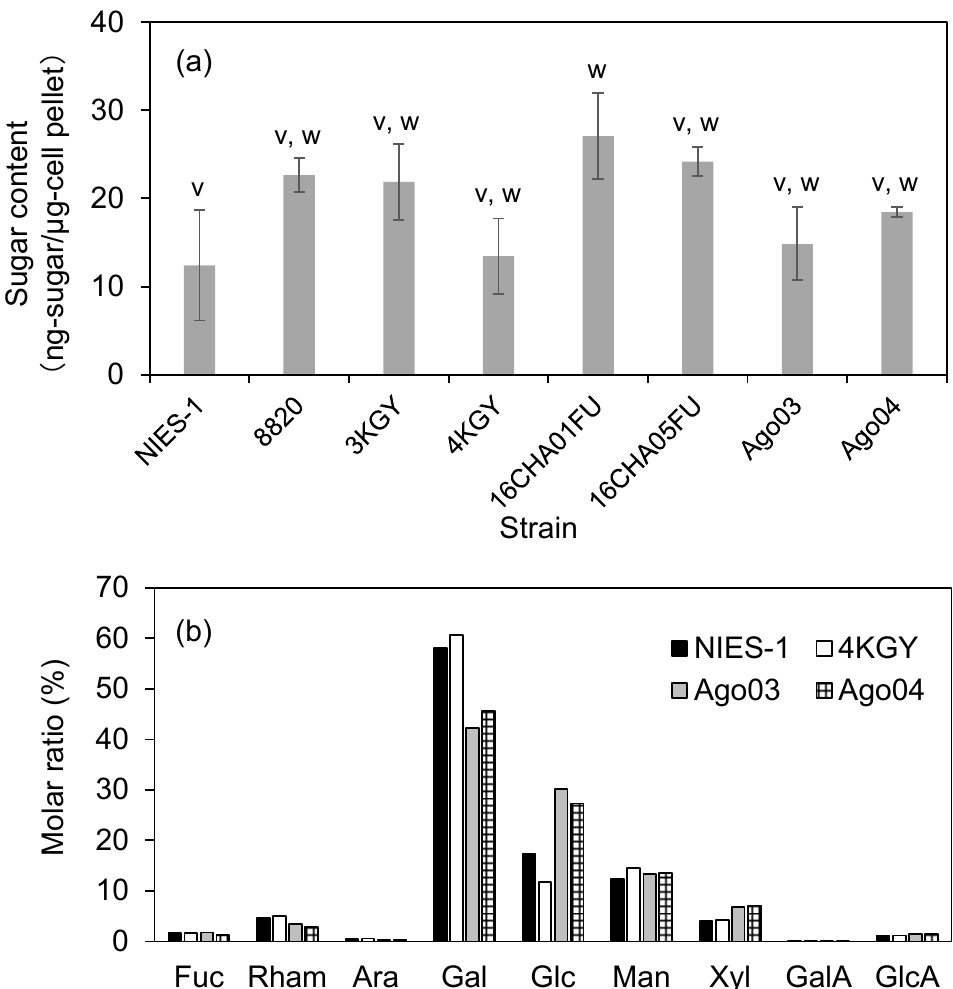
Figure 9. Sugar content ( a ) and composition of monosaccharides ( b ) of Chattonella strains. Each bar represents the mean ± SD of triplicate measurements. Means that are not significantly different are labeled with the same letter (v or w; p < 0.05). Abbreviations of sugars are as follows: Fuc, fucose; Rham, rhamnose; Ara, arabinose; Gal, galactose; Glc, glucose; Man, mannose; Xyl, xylose; GalA, galacturonic acid; GlcA, glucuronic acid.